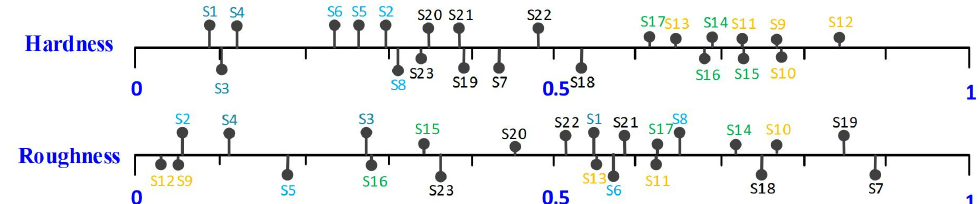
Figure 6. Hardness, Roughness intensities of the twenty-three samples. The same color indicates that the samples have the same substrate material.